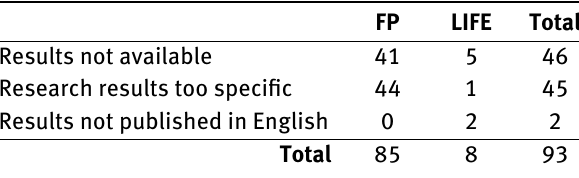
Table 3: Criterion for project exclusion (at second stage).